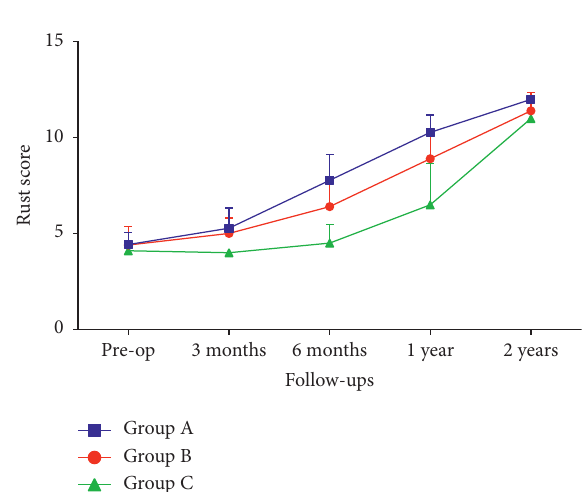
Figure 2: Graphical representation showing RUST score at sub- sequent follow-up of patients of different